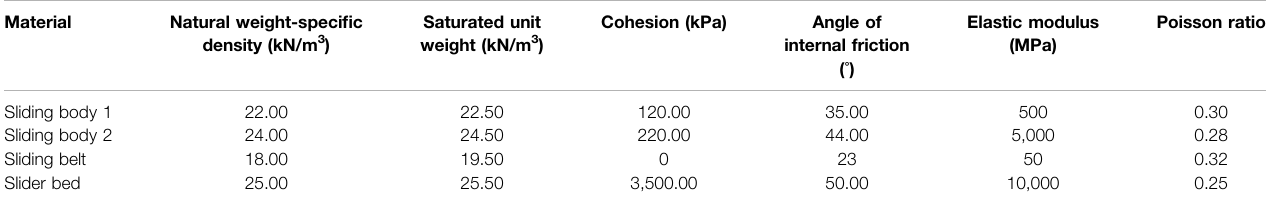
TABLE 4 | Physical and mechanical parameters of main rock and soil mass of landslide.